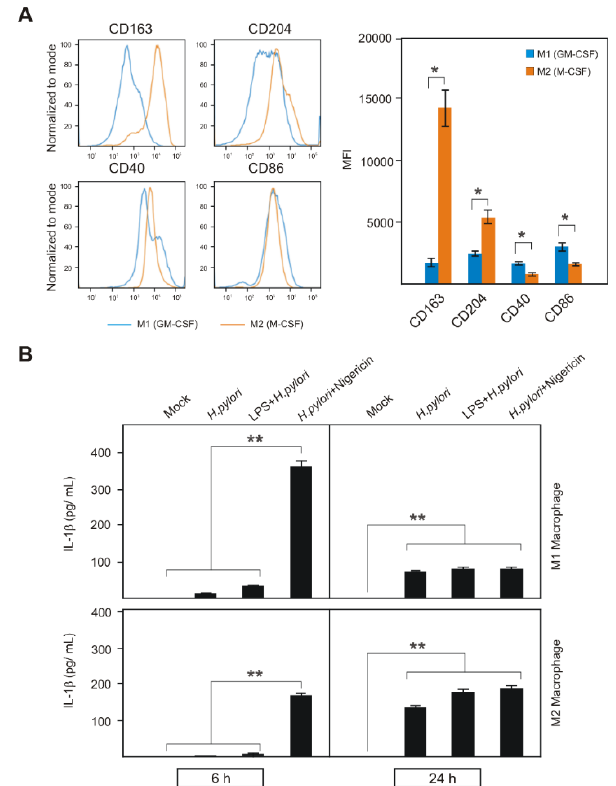
Figure 4. Primary human M1 and M2 macrophages express significantly increased amounts of M1 markers CD40, CD86 and M2 markers CD163, CD204 by flow cytometry ( A ). These M1 and M2 macrophages were infected with H. pyloi , co-treated with LPS and further treated with Nigericin to analyze NLRP3 inflammasome activation and mature IL-1β secretion ( B ). M1 and M2 macrophages showed a response that was similar to the THP1 monocytes. * p ≤ 0.05; ** p ≤